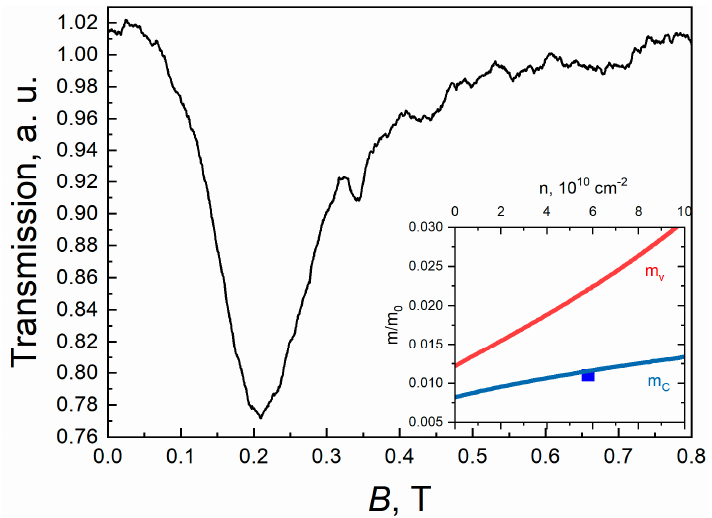
Figure 4. CR spectra and calculated cyclotron masses for electrons (m e ) and holes (m v ) vs. carrier density (m 0 denotes the free electron mass) for sample #A0130 at T = 4.2K. The measurement frequency is 526 GHz (corresponding to the photon energy of 2.17 meV).